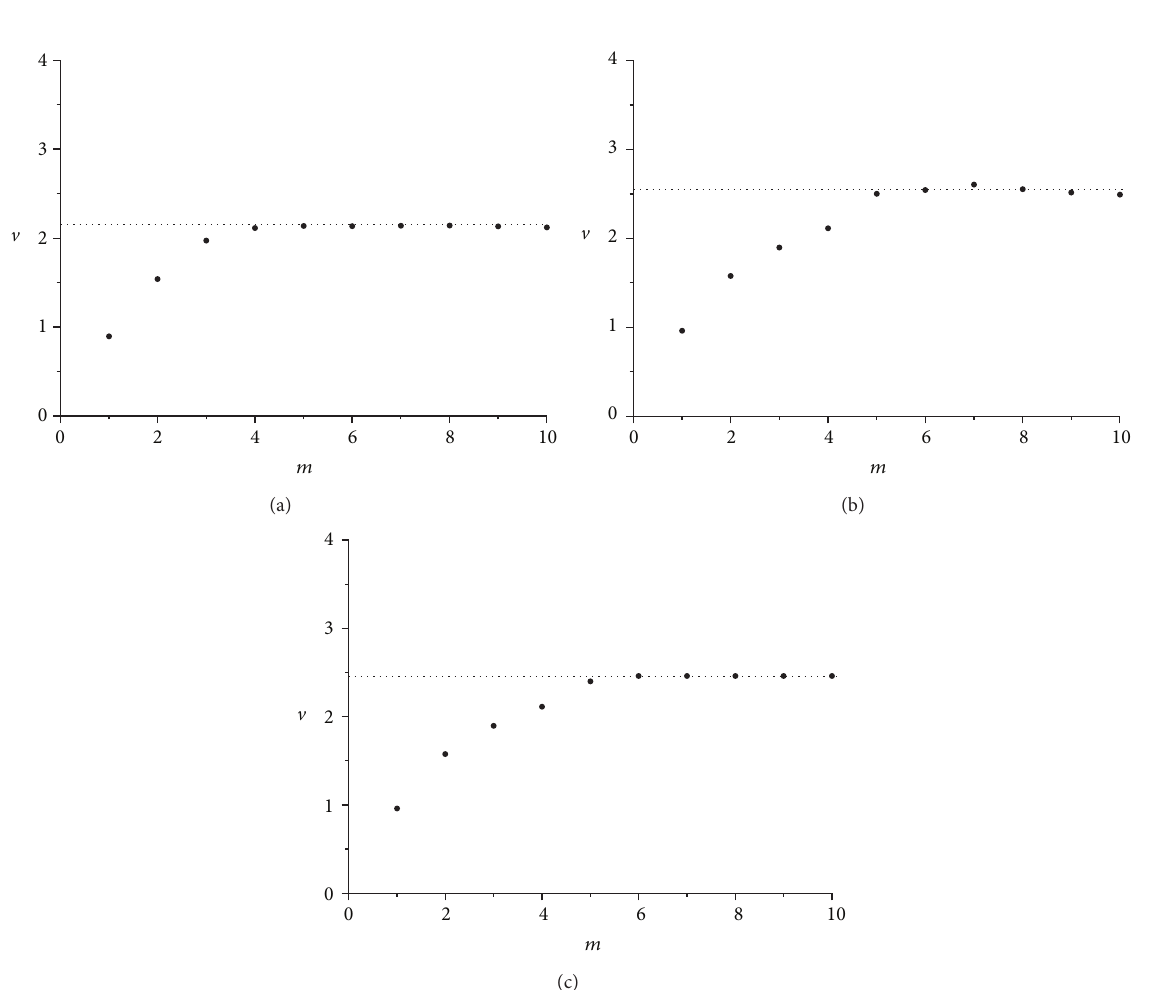
between 𝛿 the ellipsoid’s vertical axis and the plain surface